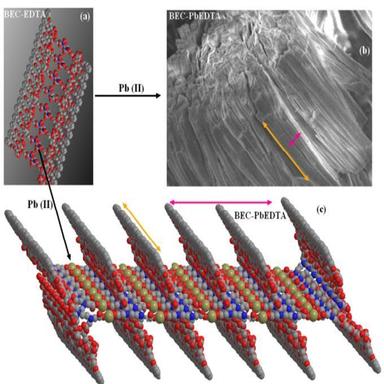
(a) "Railway" structure; (b) SEM image and (c) supramolecular structure proposed of BEC-PbEDTA